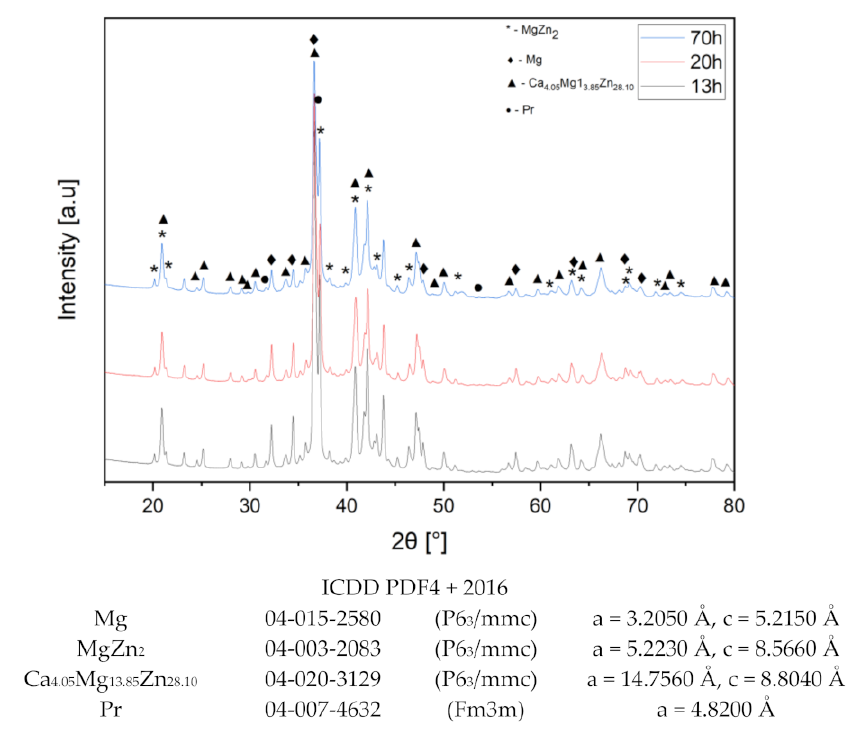
Figure 3. Phase analysis of the selected Mg-Zn-Ca-Pr alloy samples (milled for 13, 20 and 70 h) sintered from milled powders.